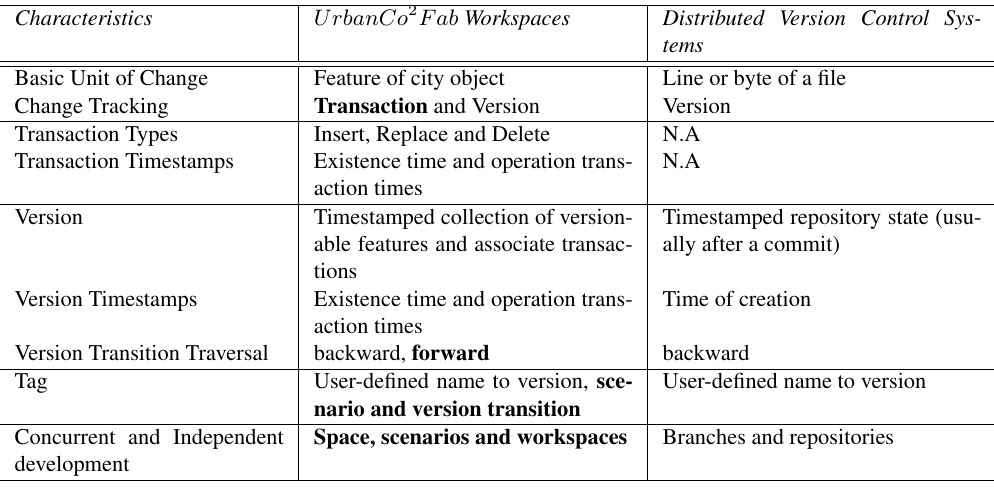
Table 1. Comparison between UrbanCo 2 Fab Workspaces and Distributed Version Control Systems. Key differences are highlighted